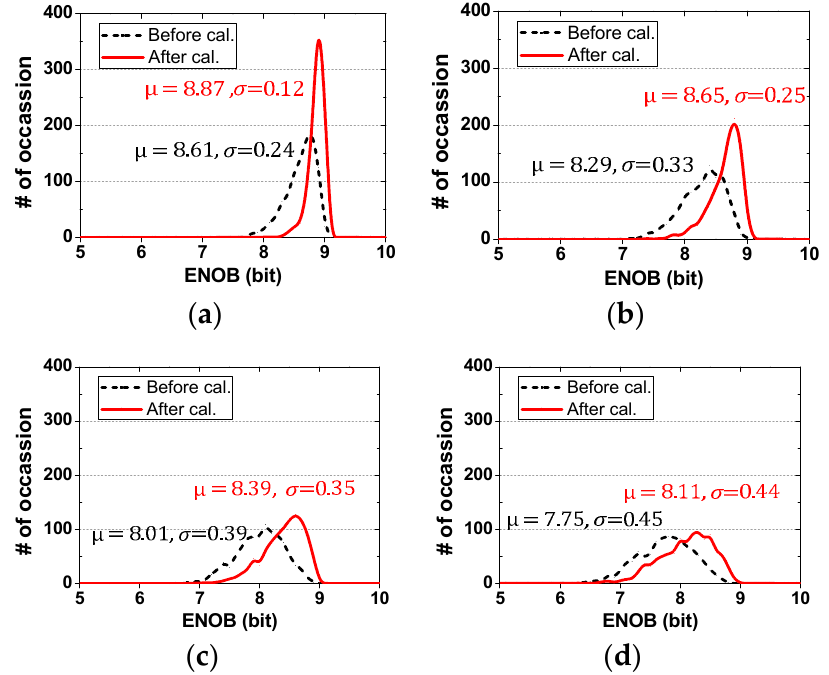
Figure 16. Probability distributions of an effective number of bits (ENOB) before and after DAC capacitor mismatch calibration. Capacitor mismatches are ( a ) 1.0%, ( b ) 1.5%, ( c ) 2.0%, ( d ) 2.5%.